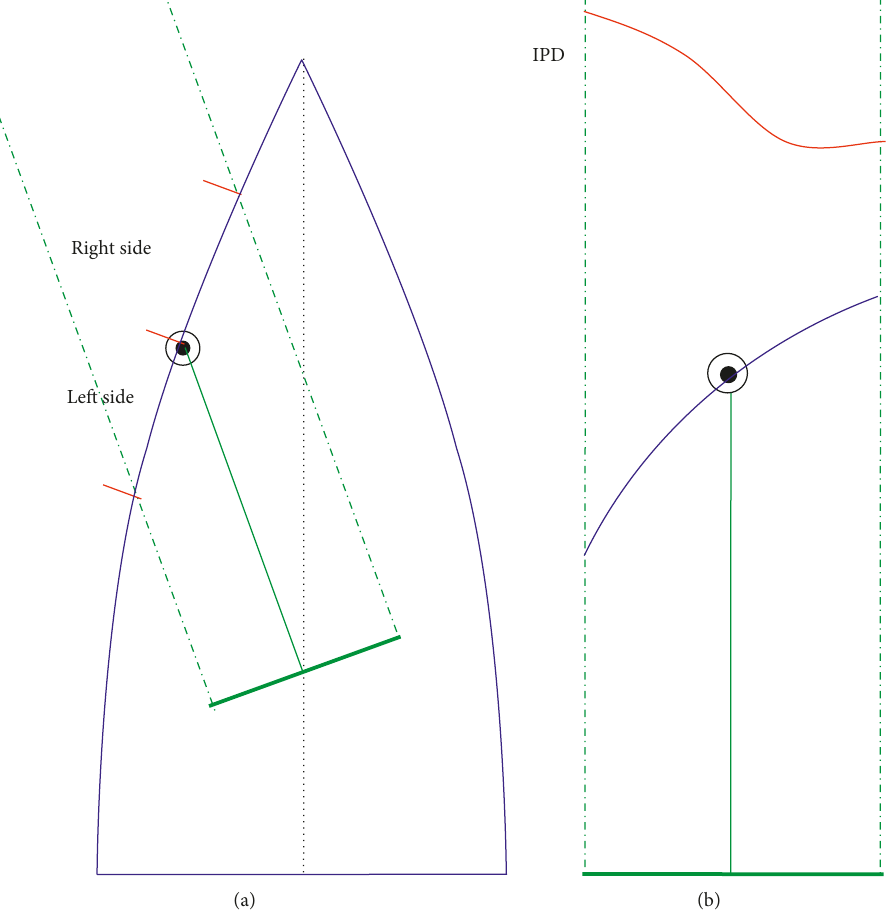
Figure 1: 2D case of the antenna-radome system. (a) Overall view. (b) Partial view with IPD.